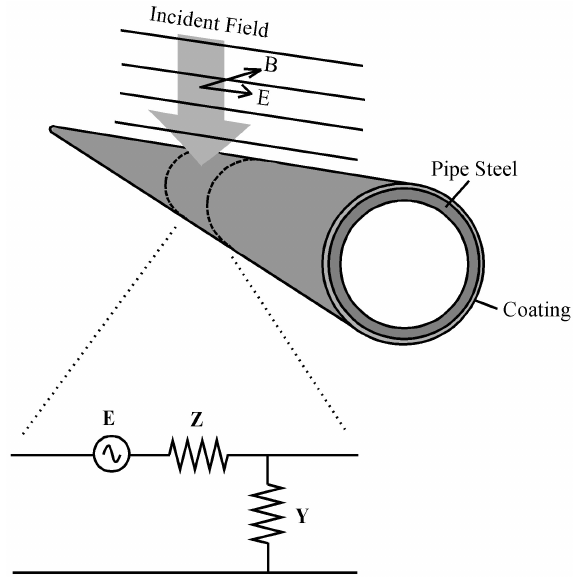
Fig. 6. Transmission line model of pipeline including distributed voltage sources representing the induced electric field.